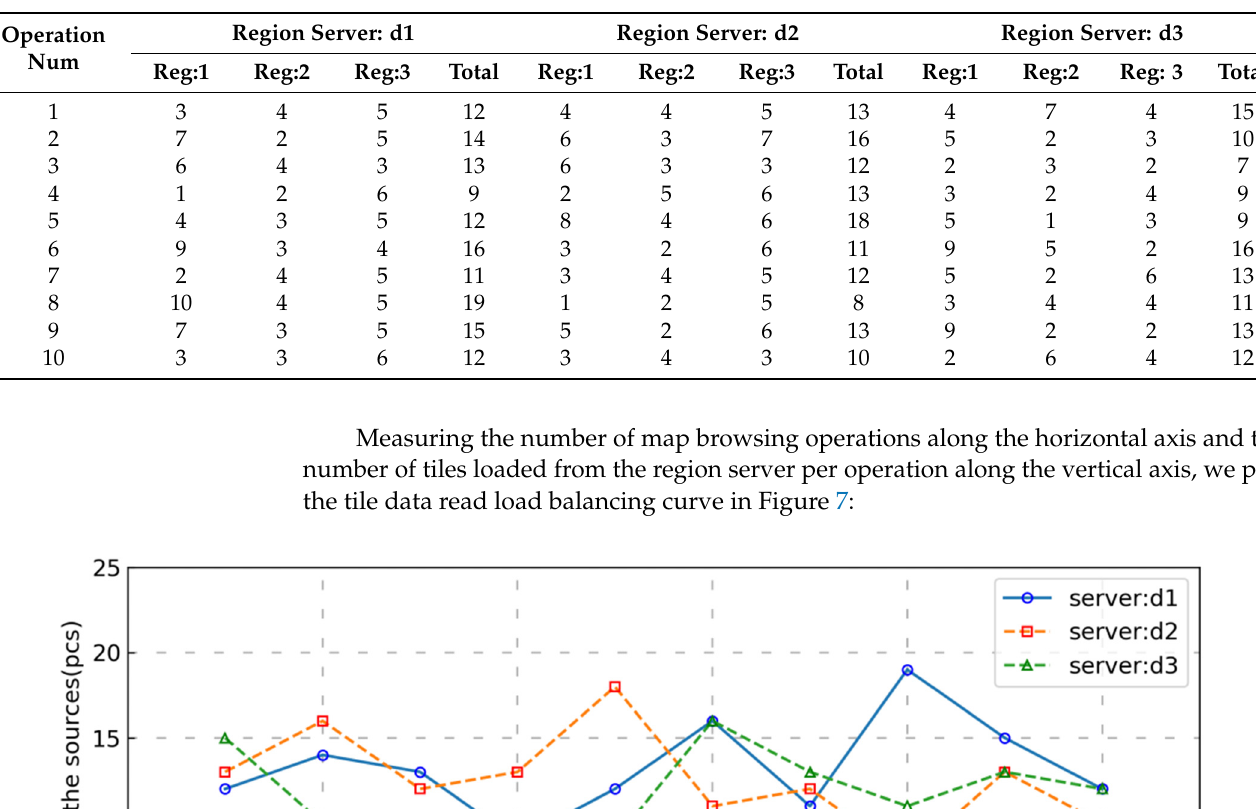
Table 3. Tile data source for the same map view.